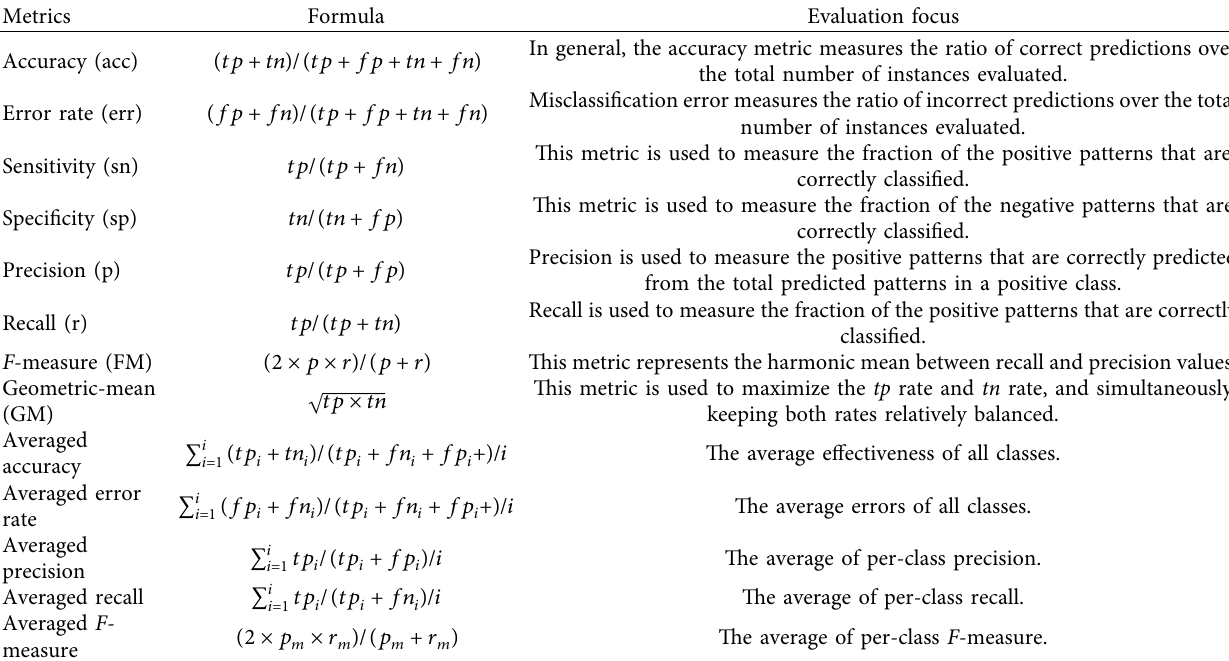
Table 1: The threshold metrics for classification evaluations.